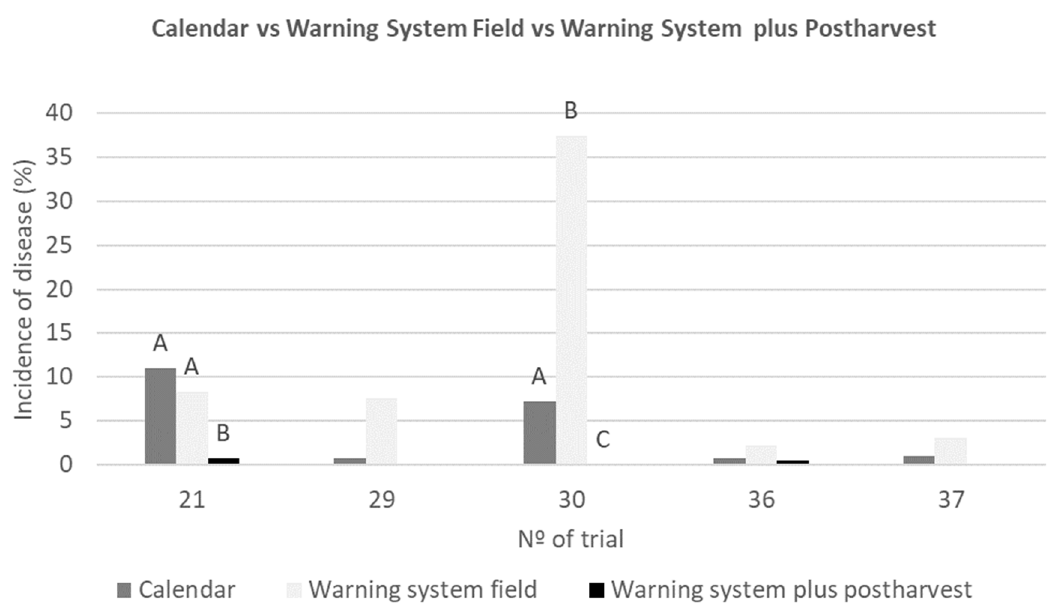
Figure 7. Incidence of disease recorded in postharvest, after 7 days a 20 °C and 85% RH in fruit treated by calendar ( ), by warning system applied in the field ( ) and warning system applied in the field plus the postharvest treatment ( ). For each trial, when mean values have different letters indicated statistical differences between the incidence of disease recorded according to Student’s LSD ( p ‐ value < 0.05).